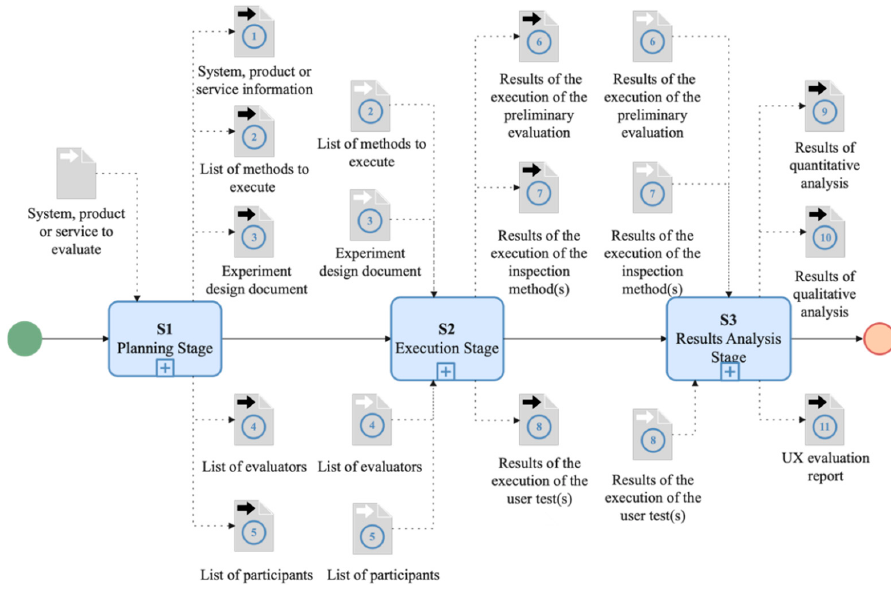
Figure 3. General description of the methodology.